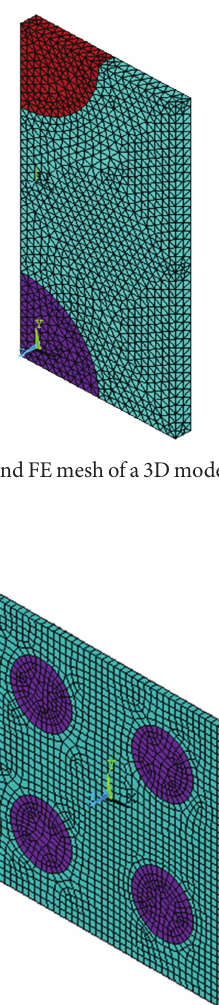
Figure 8: Geometry and FE mesh of a 3D model for case